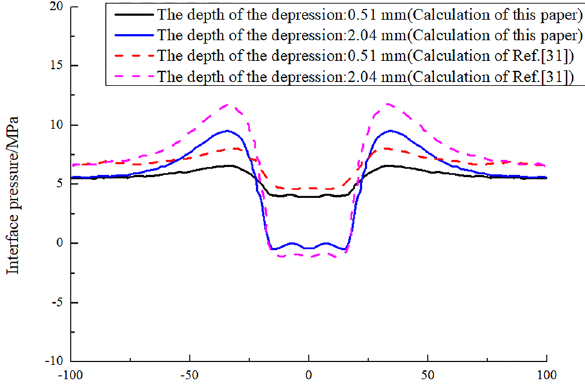
Figure 4: Comparison of interface pressure distribution calculations.